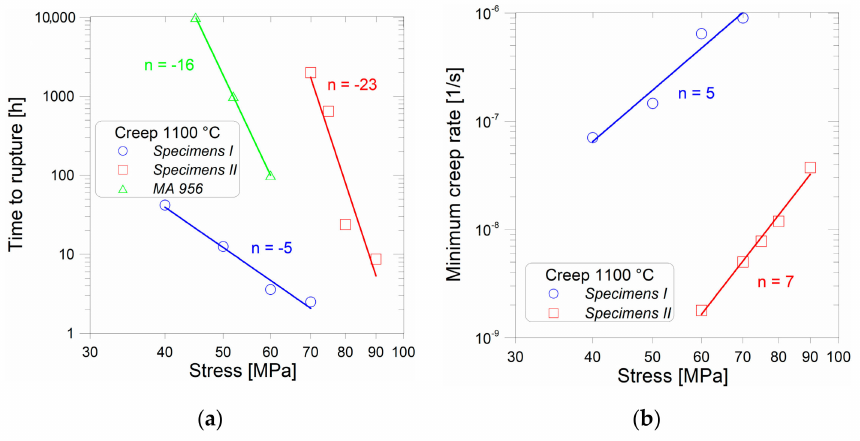
Figure 3. Comparison of ( a ) time to rupture; ( b ) minimum creep rate for Specimens I and II. Interrupted creep test of Specimens II at 60 MPa is used to determine the minimum creep rate.